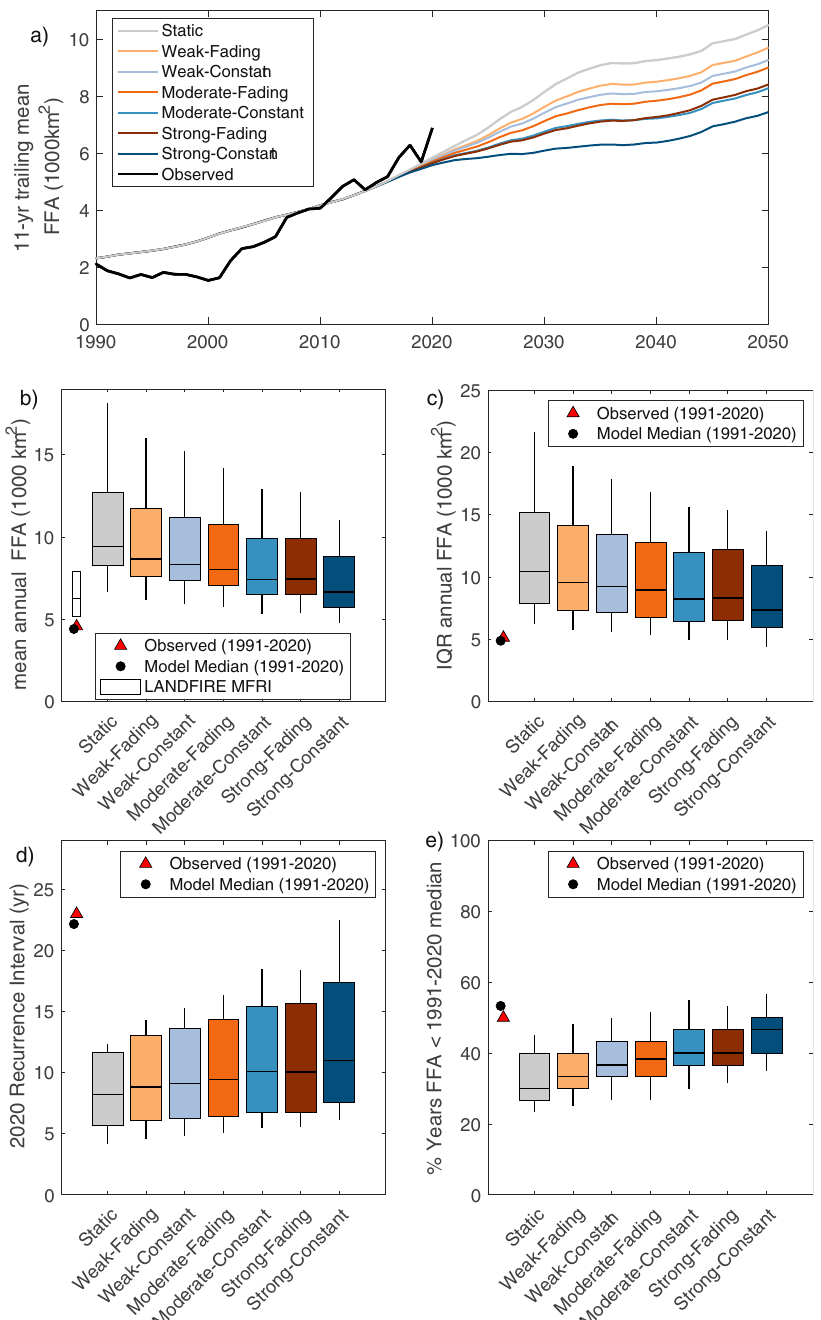
Fig. 3 Forest- fi re area (FFA) projections (2021 – 2050) using static and dynamic models. Shown are ( a ) time series of trailing 11-year moving average forest- fi re area, b average annual forest- fi re area, c interquartile range, median and the 10th and 90th percentile for the average annual burned area, d recurrence interval of the forest- fi re area exceeding the 2020 fi re season, and ( e ) percent of years with a forest- fi re area less than the 1991 – 2020 observed median. a Results for the multi-model median. Boxplots show the median, interquartile range, and 10 – 90th percentiles from climate models. The observed and modeled forest- fi re area-averaged over the 1991 – 2020 period are shown by the red triangle and black dot, respectively. Estimated ranges in the annual forest- fi re area corresponding to pre-European colonization are shown by the white bar in ( b ). Fire model descriptions are provided in Supplementary Table